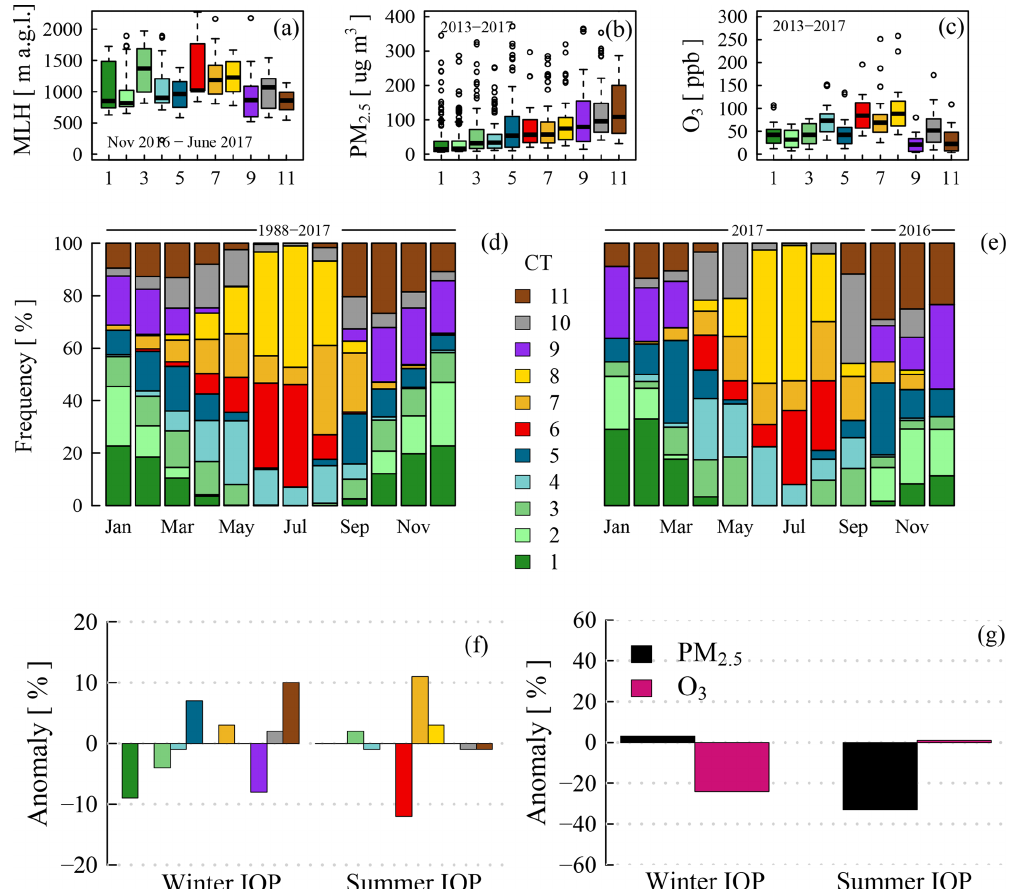
Figure 10. Analysis by circulation type (CT; Sect. 4.3) of (a) daily maximum mixed layer height (MLH) determined from ALC observations at IAP between November 2016 and June 2017 (analysis method; Kotthaus and Grimmond, 2018b); concentration of (b) PM 2 . 5 and (c) O 3 at the Olympic Park (i.e. Aoti Zhongxin, Fig. 1) in 2013–2017 from the national air quality network for different CTs; occurrence of CTs in (d) 1988–2017 and (e) October 2016–September 2017; (f) anomaly of CT frequency during the campaigns compared to 5-year (2013–2017) averages; and (g) anomaly of PM 2 . 5 and O 3 during the campaigns compared to 5-year (2013–2017) averages. IOP is the intensive observation period (i.e. campaign